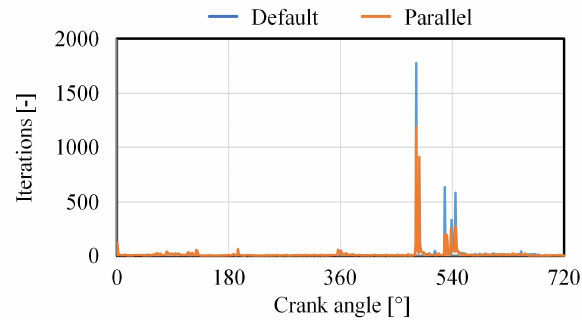
Figure 8. The number of iterations of the piston–liner multibody dynamics simulation with elastohydrodynamic lubrication. The values are plotted depending on the crankshaft angular position.